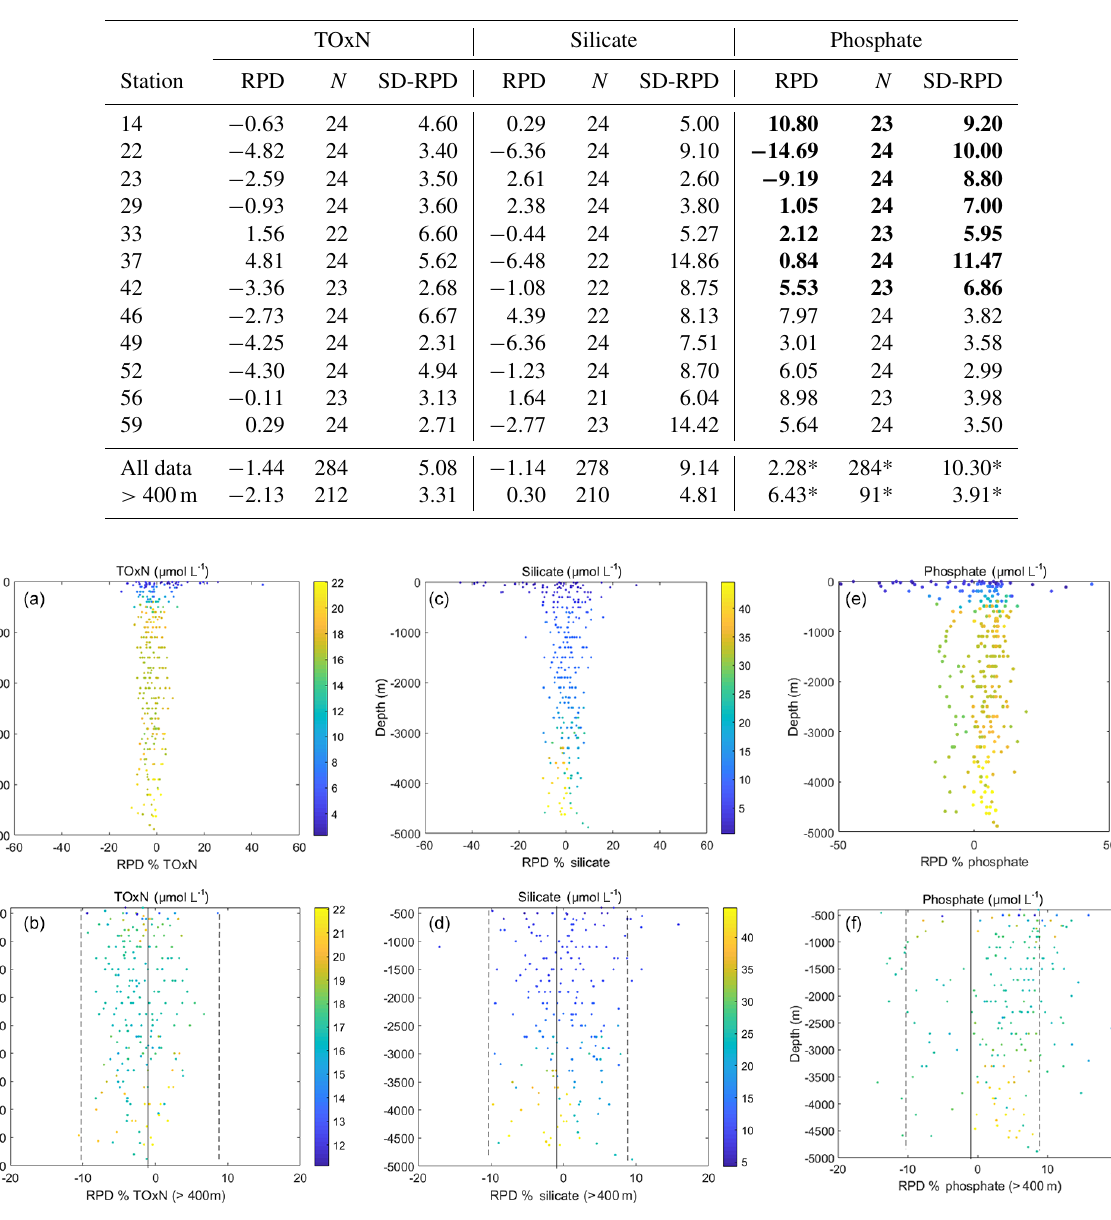
Table 5. Relative percentage difference (RPD MI − DAL ) calculated as (MI conc − Dal conc) / average conc × 100% for each station in the intercomparison study. N represents the number of samples, and SD-RPD is the standard deviation. Bold font represents the stations analysed prior to Station 46 (i.e. before the phosphate standard curve was altered; see details in Table 2). “All data” refers to all water samples which were measured by both MI and Dal during the cruise and “ > 400m” refers to all samples from below 400m that were analysed by both groups. Asterisks (*) for phosphate values denote that the statistic refers only to samples from Station 46 onwards.